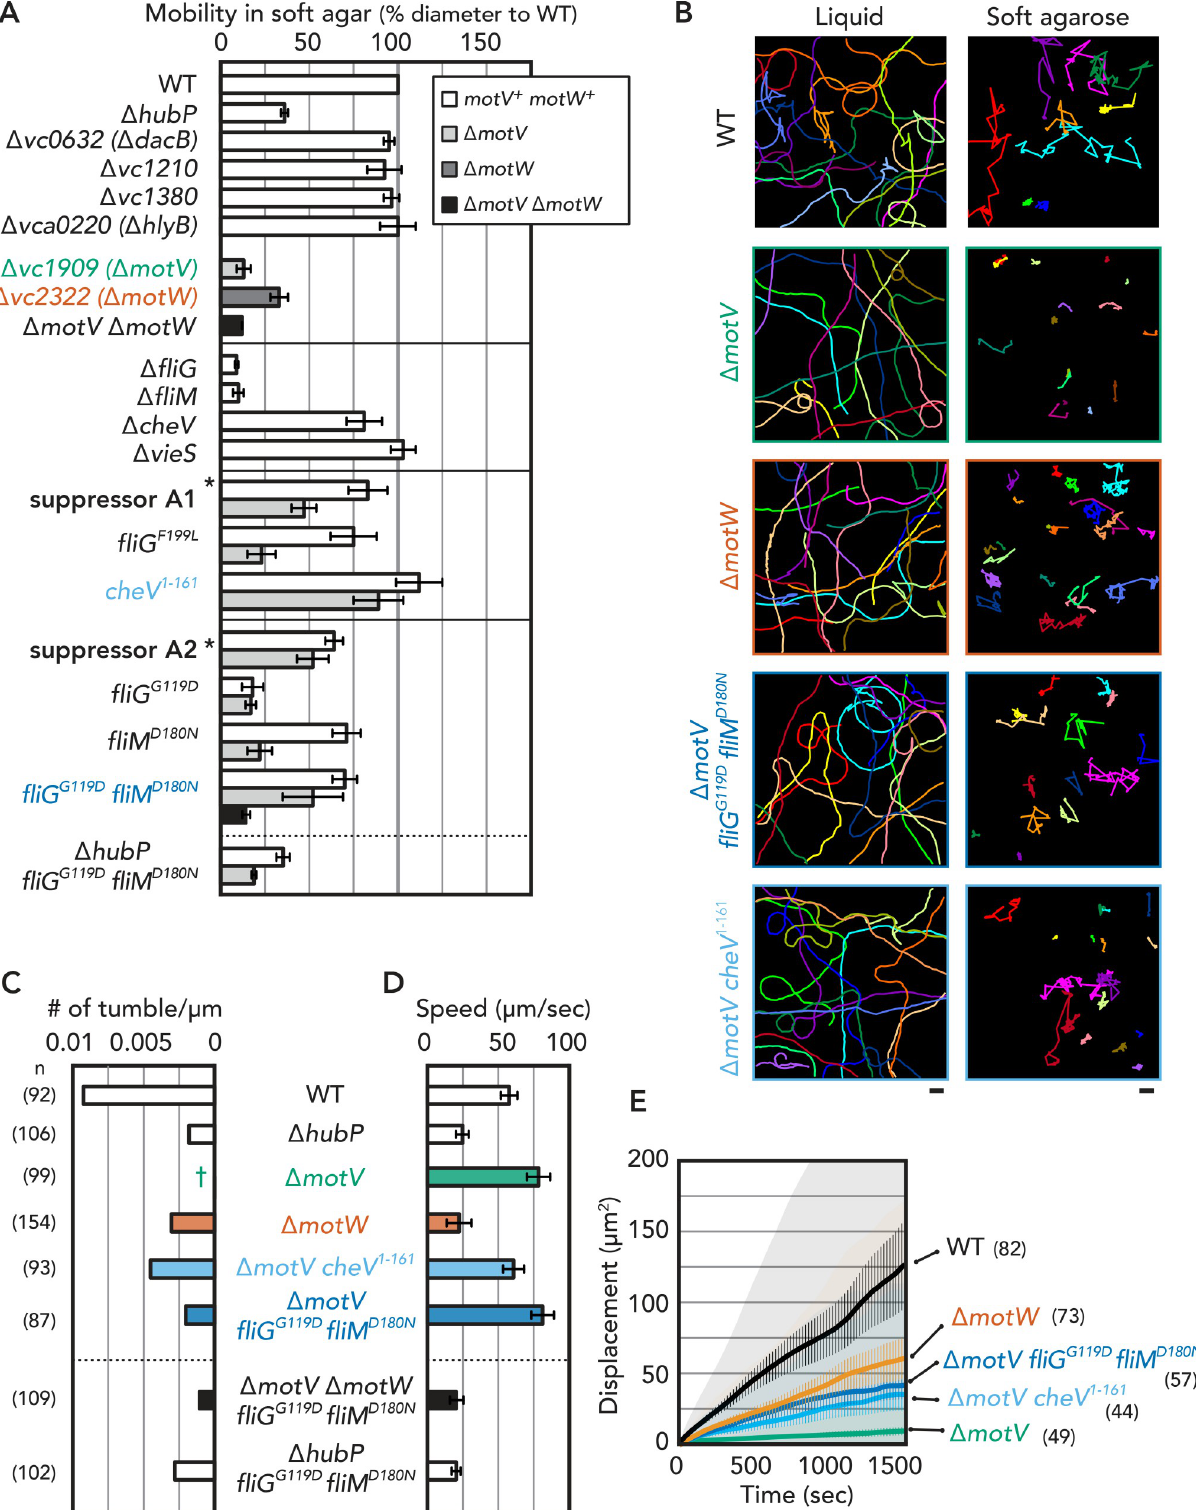
Fig 3. Motility of V . cholerae mutants. (A) Motility defects examined by swimming in soft agar plates. Average diameter relative to WT, along with standard deviations from at least three experiments are shown. Only limited number of strains are shown and the exhaustive results can be found in